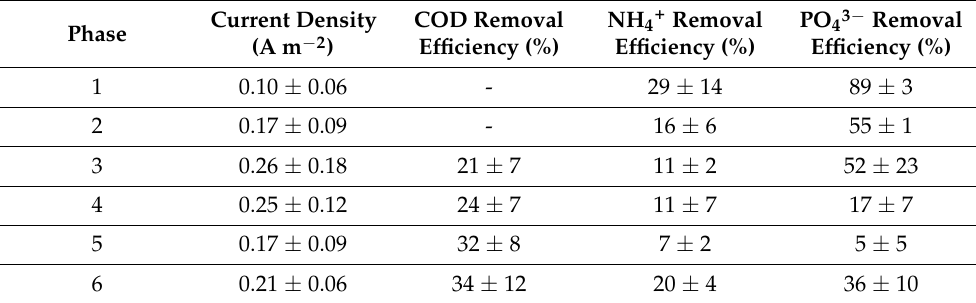
Table 3. Summary of the main operation parameters of the MEC in the different phases of digestate operation (average ± standard deviation). Phase 1: not amended feeding was used ( n = 7); Phase 2: catholyte acidified to pH 6 ( n = 4); Phase 3; catholyte acidified to pH 5 ( n = 8); Phase 4: catholyte acidified to pH 5 and phosphate amended ( n = 6); Phase 5: phosphate amended catholyte ( n = 4); Phase 6: phosphate amended anolyte ( n =